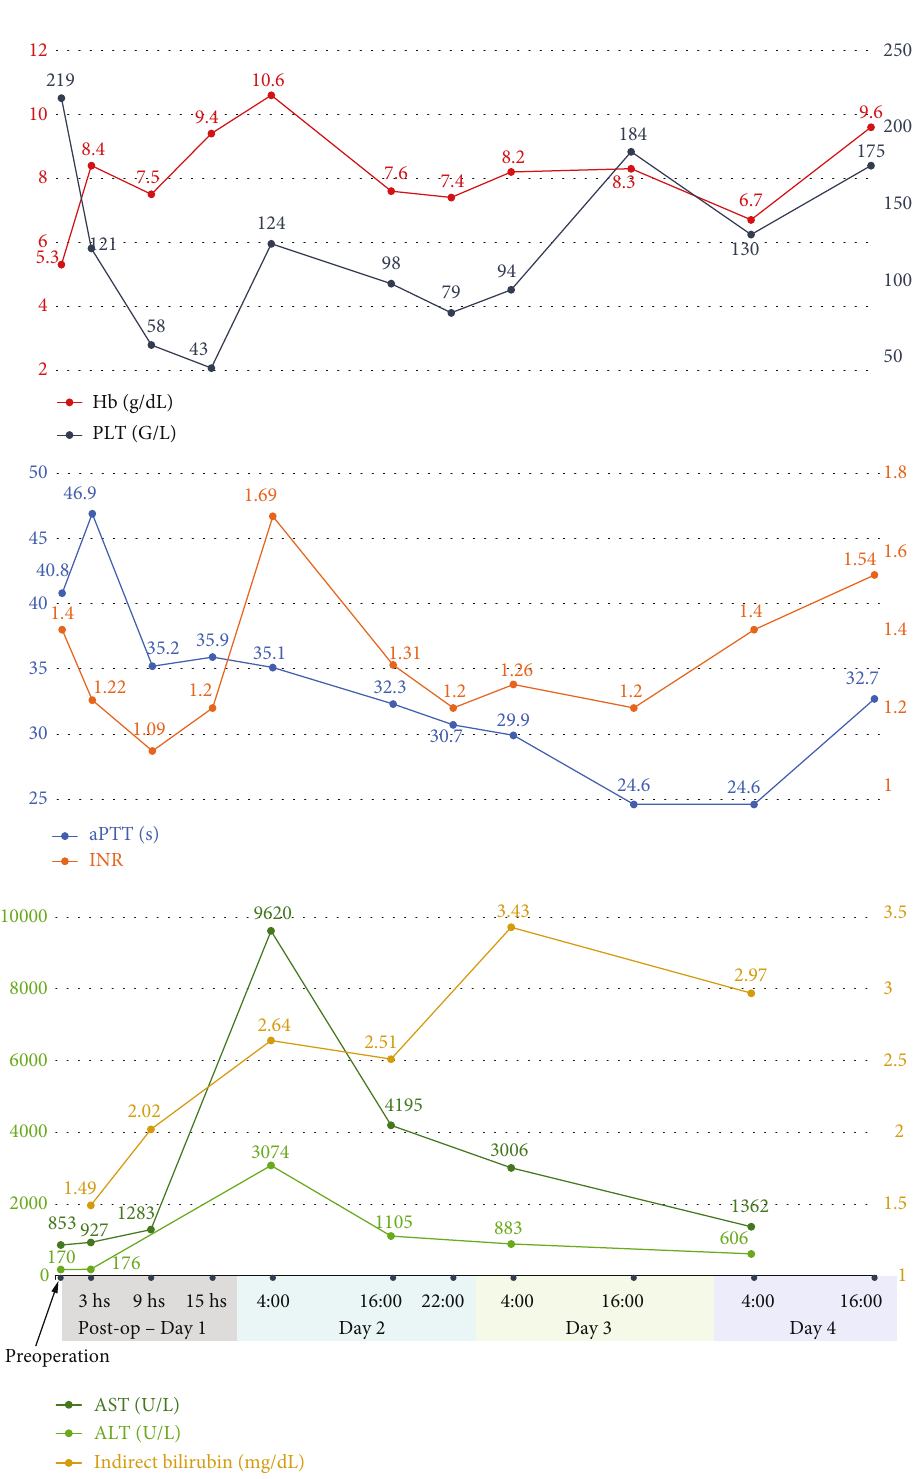
Figure 3: Variation of serum laboratory results over